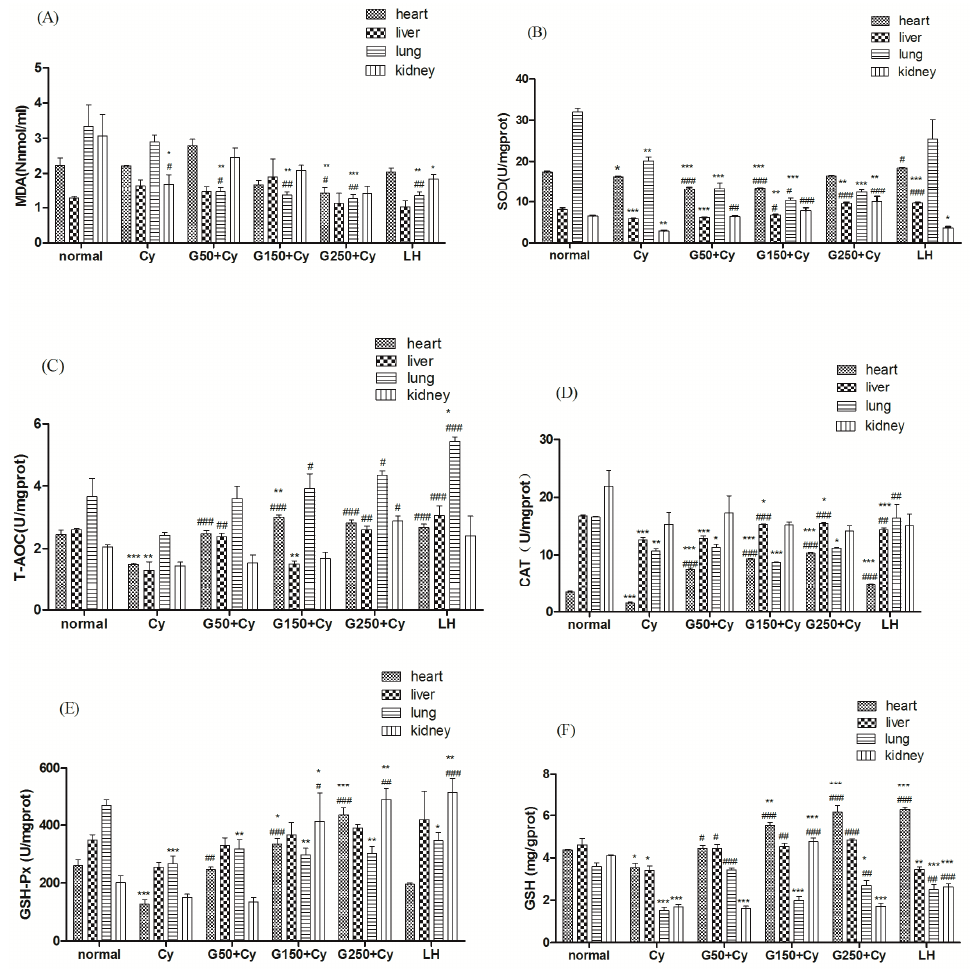
Figure 6. Effect of GPMPP on the ( A ) MDA level, and the activities of ( B ) SOD; ( C ) T-AOC; ( D ) CAT; ( E ) GSH-Px and ( F ) GSH in the heart, liver, lung and kidney of Cy-immunosuppressed mice. * p < 0.05, ** p < 0.01, *** p < 0.001, compared with normal control. # p < 0.05, ## p < 0.01, ### p < 0.001, compared with model control. Values are means ± SD, n = 10.